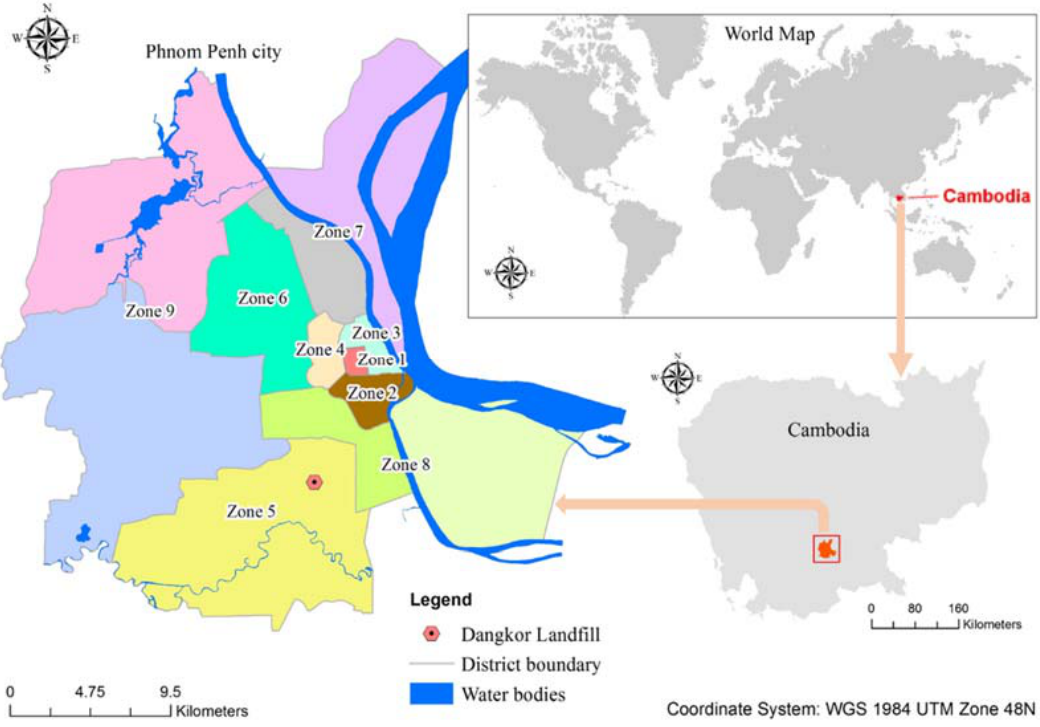
Fig. 2: Location of the study area